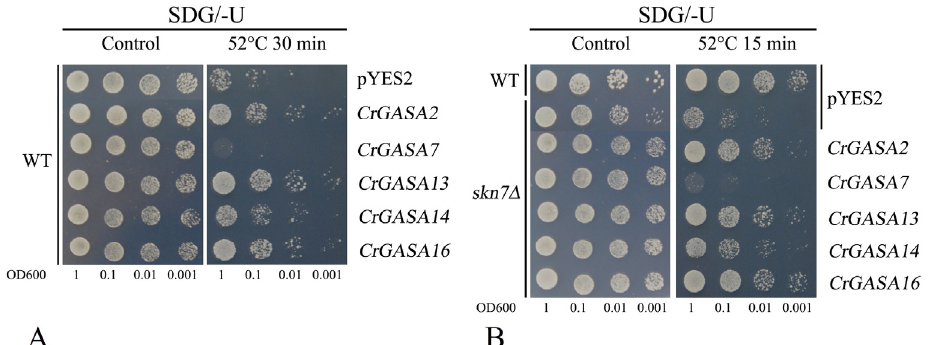
Figure 12. The thermotolerance confirmation in yeast strains WT ( A ) and skn7 Δ ( B ) by expressing five CrGASA s. Yeast cultures (with or without heat stress challenges, WT: 52 °C for 30 min; skn7 Δ : 52 °C for 15 min) were adjusted to OD600 = 1, and 2 μ L serial dilutions (10-fold) were spotted on SDG-Ura medium plates. The plates were incubated for 2–5 days at 30 °C.